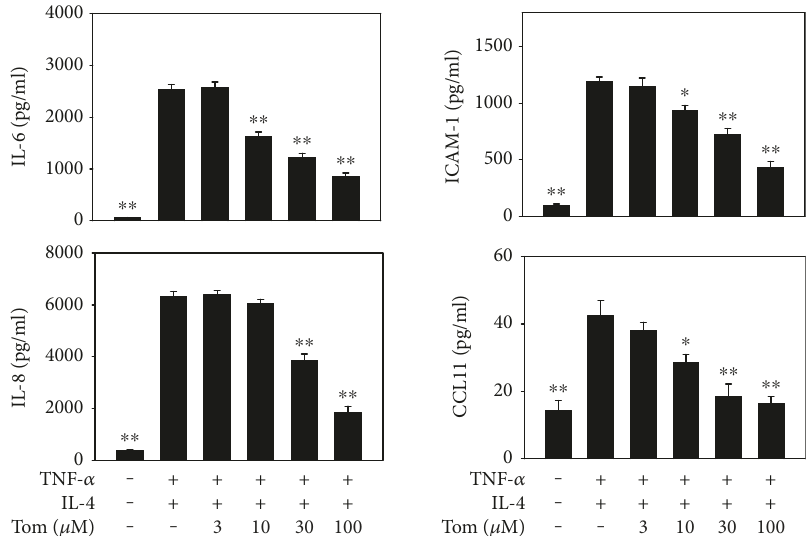
Figure 7: Tomatidine suppressed cytokine and chemokine levels in BEAS-2B cells. BEAS-2B cells treated with the indicated concentrations of tomatidine (Tom) for 1h were cultured with 20 ng/ml TNF- α and 5 ng/ml IL-4 for 24h. The supernatant was collected and the levels of IL-6, IL-8, ICAM-1, and CCL11 were measured by ELISA. All data are presented as means ± SEM. ∗ P < 0 05 , ∗∗ P < 0 01 compared to the OVA control